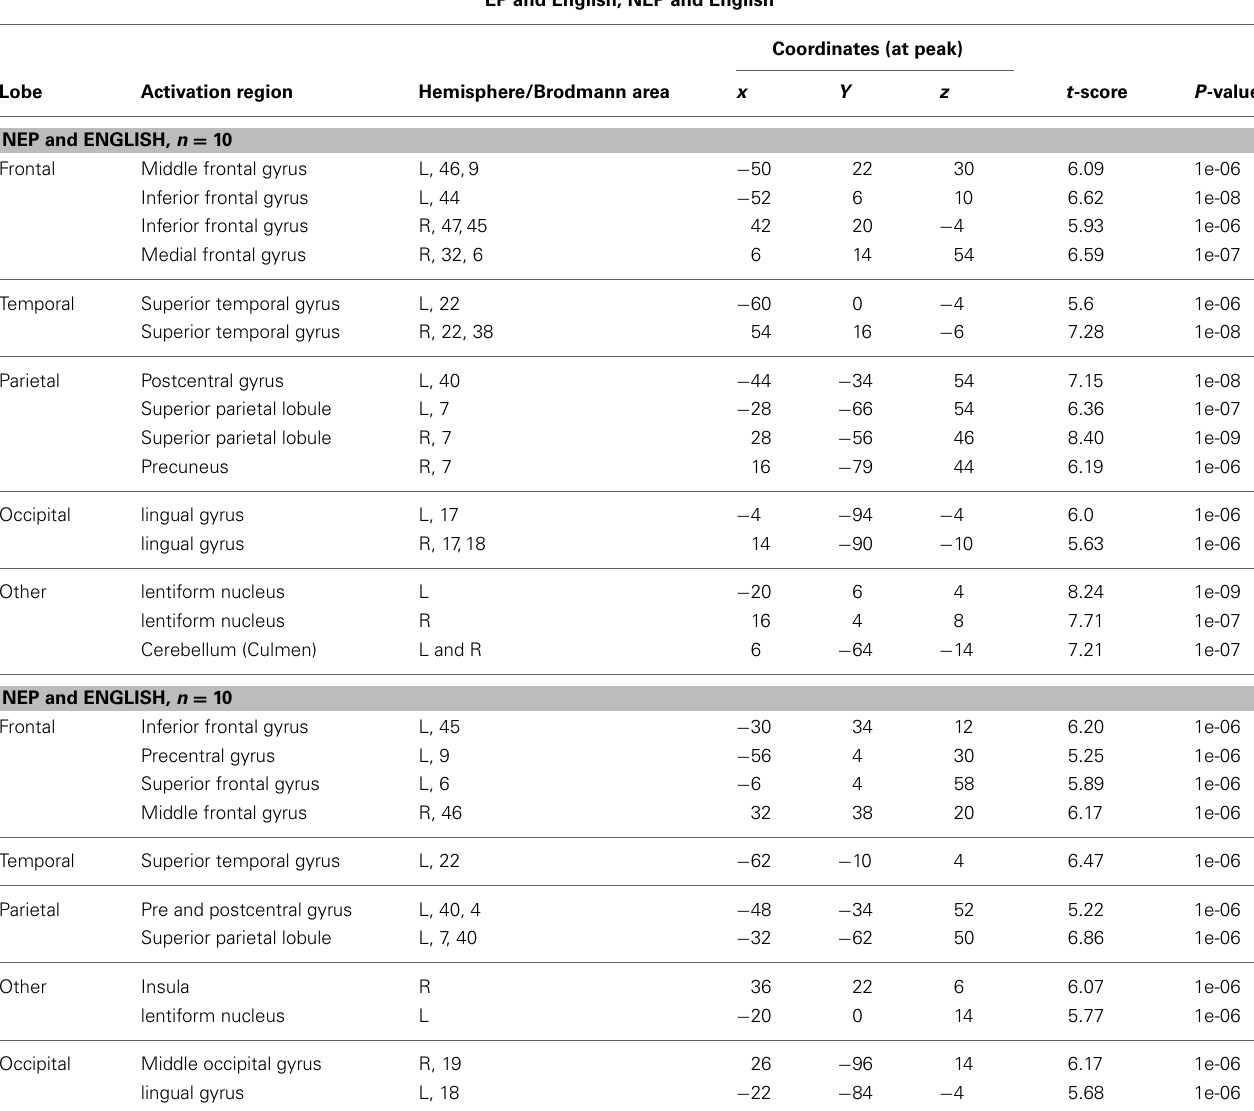
EP and English; NEP and